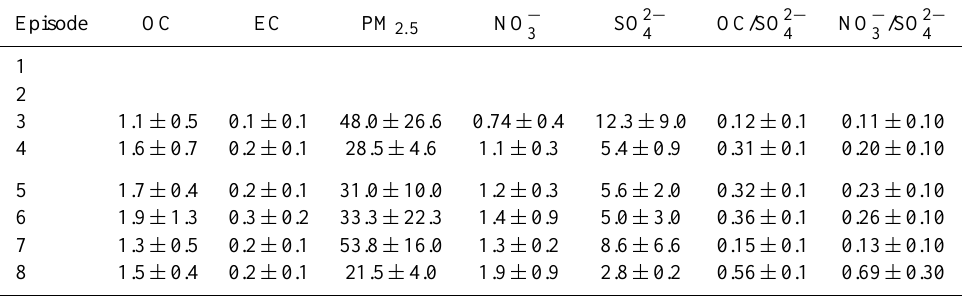
Table 2. Mass data (µgm − 3 ) for Asian pollution transport episodes observed during CAPMEX. The uncertainty represents one standard deviation of the mean of the daily mass or ratio determined for each day in the episode. The last two columns are composition ratios and are